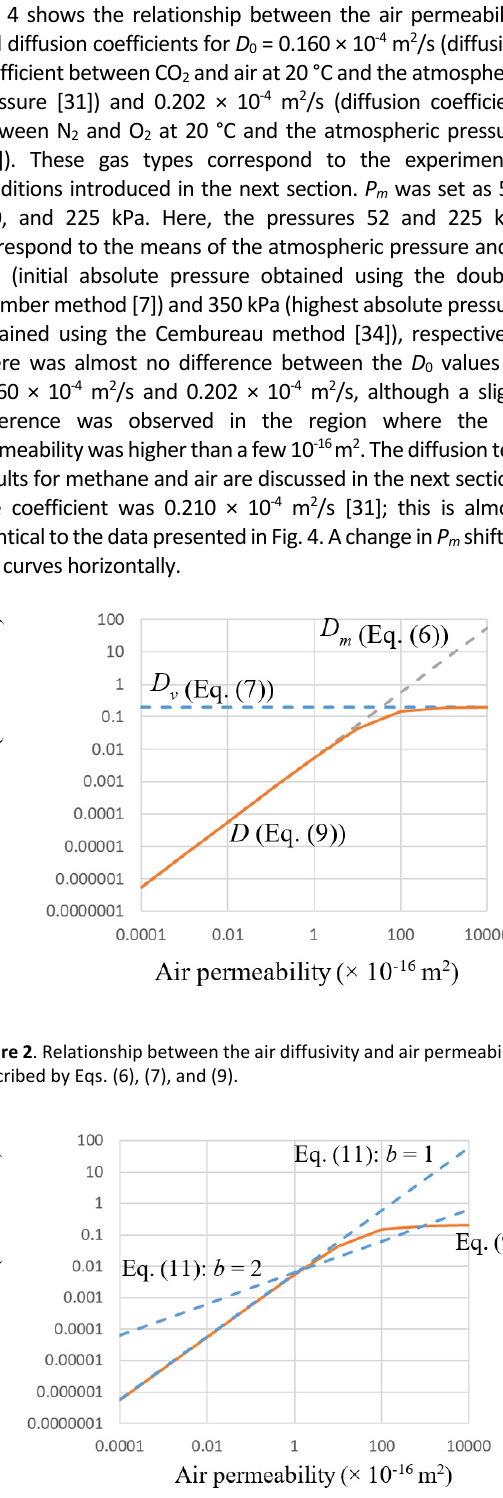
Figure 3. Relationship between the air diffusivity and permeability described by Eqs. (9) and